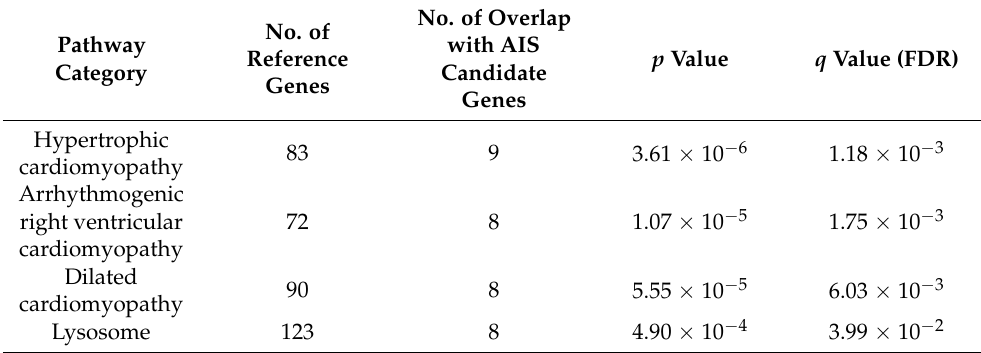
Table 4. KEGG pathways enriched in AIS candidate